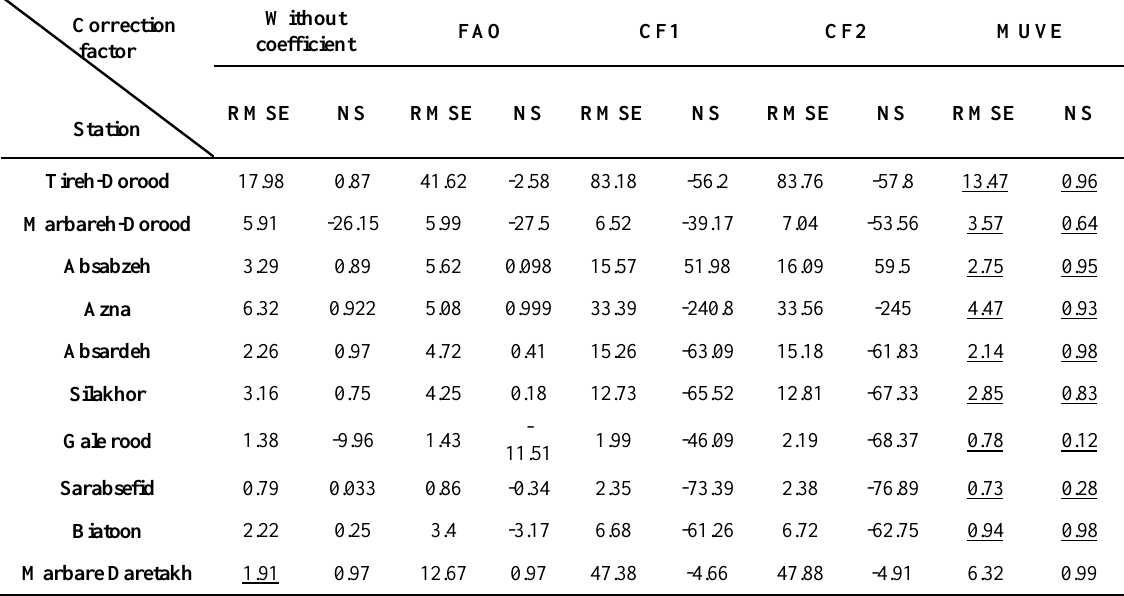
Table 1. Results of using different bias correction factors on monthly SRC (the most appropriate sediment rating curve) Correction factor